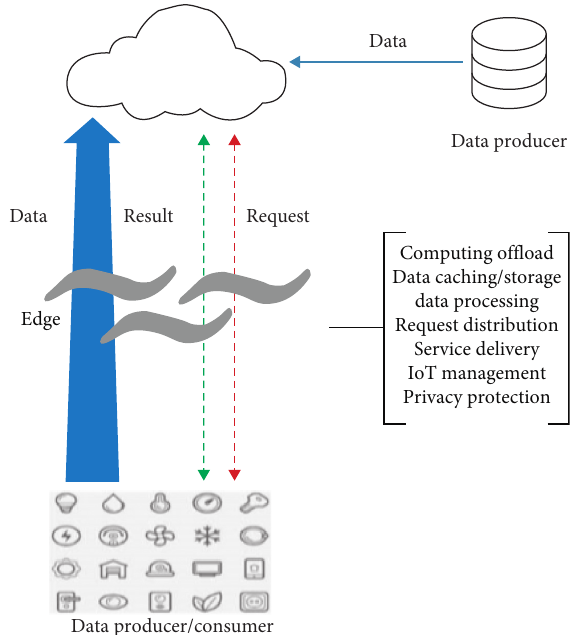
Figure 3: Structure of edge computing